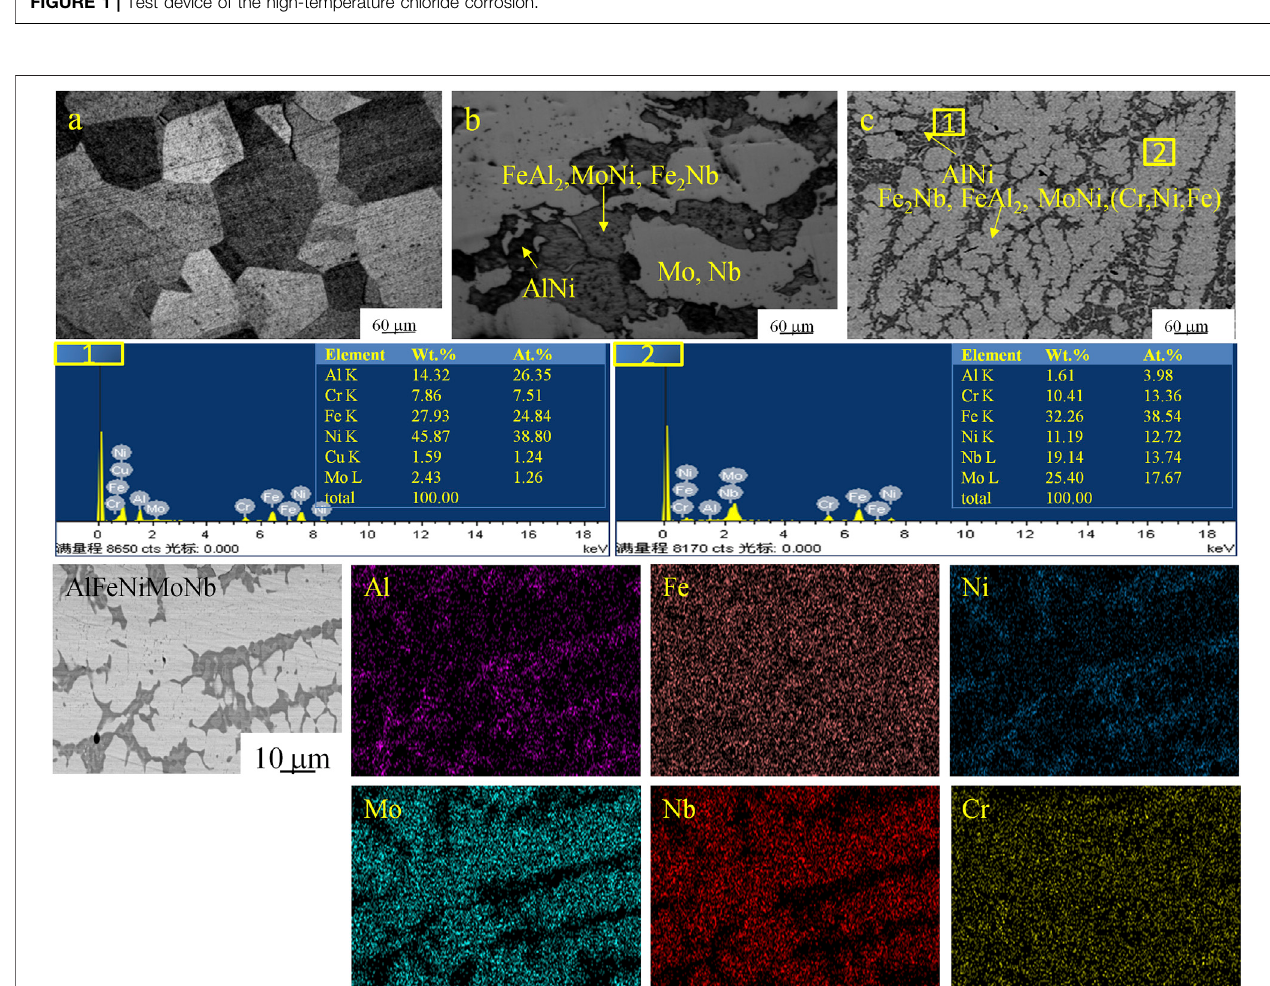
FIGURE 2 | Metallographic pictures of the tested alloys and energy dispersive spectroscopy (EDS) results of 904L:AlFeNiMoNb. (A) : 904L; (B) : AlFeNiMoNb; (C) : 904L:AlFeNiMoNb.